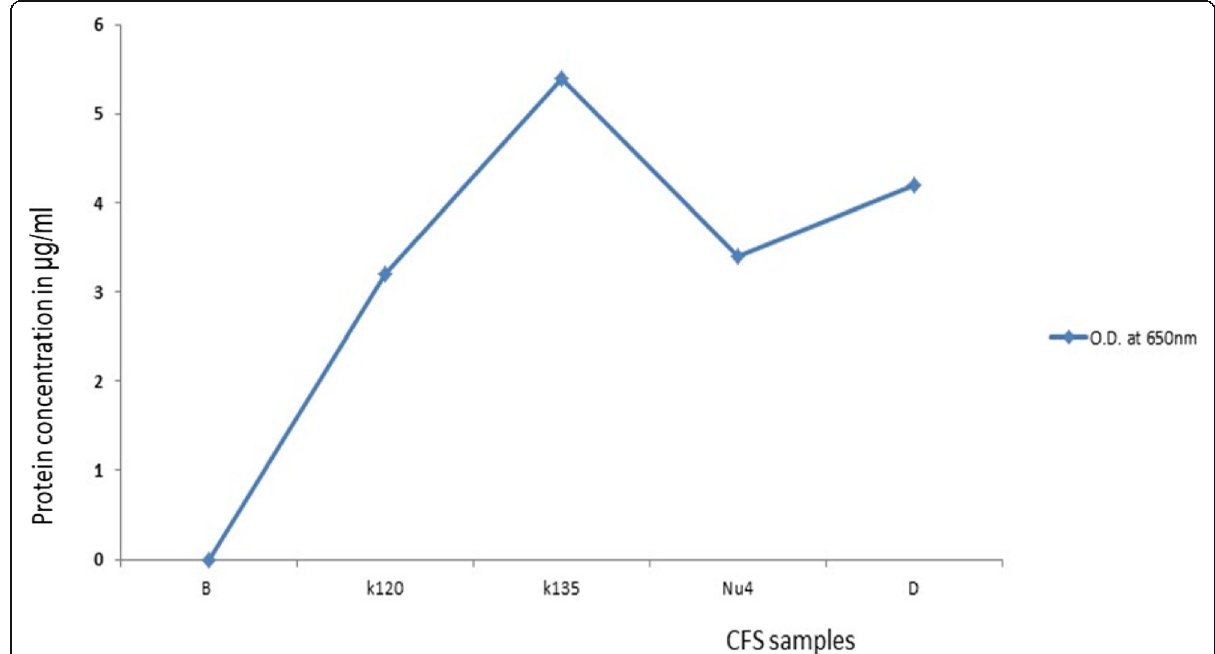
Fig. 5 Protein estimation in dialysate using Lowry ’ s